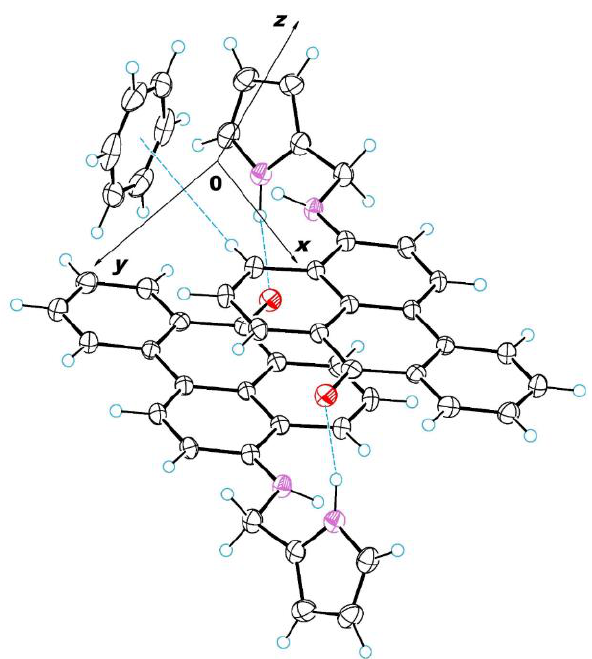
Figure 4. A fragment of molecular packing of 3a showing N − H ··· O and C − H ··· π hydrogen bonds.